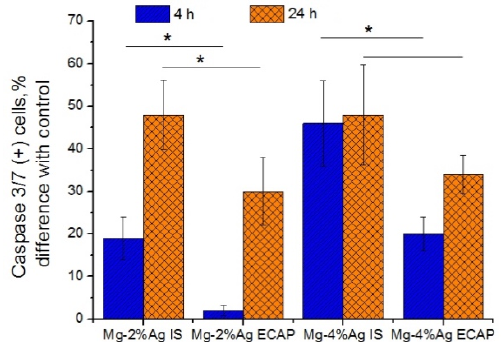
Figure 9. Increase of Caspase 3/7 (+) cells concentration after incubation with samples of Mg-2.0%Ag and Mg-4.0%Ag alloys in the initial state and after ECAP in comparison with the control (* p < 0.05).